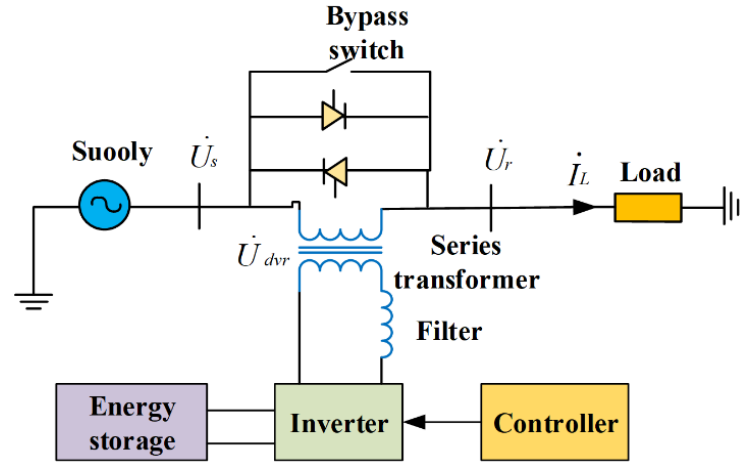
Figure 1. Principle diagram of the proposed EOC-DVR.